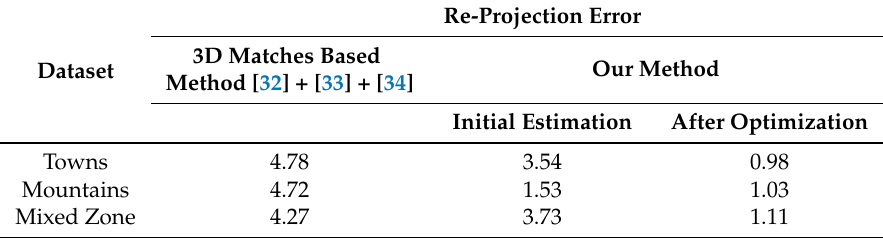
Table 3. The re-projection error for experimental comparison